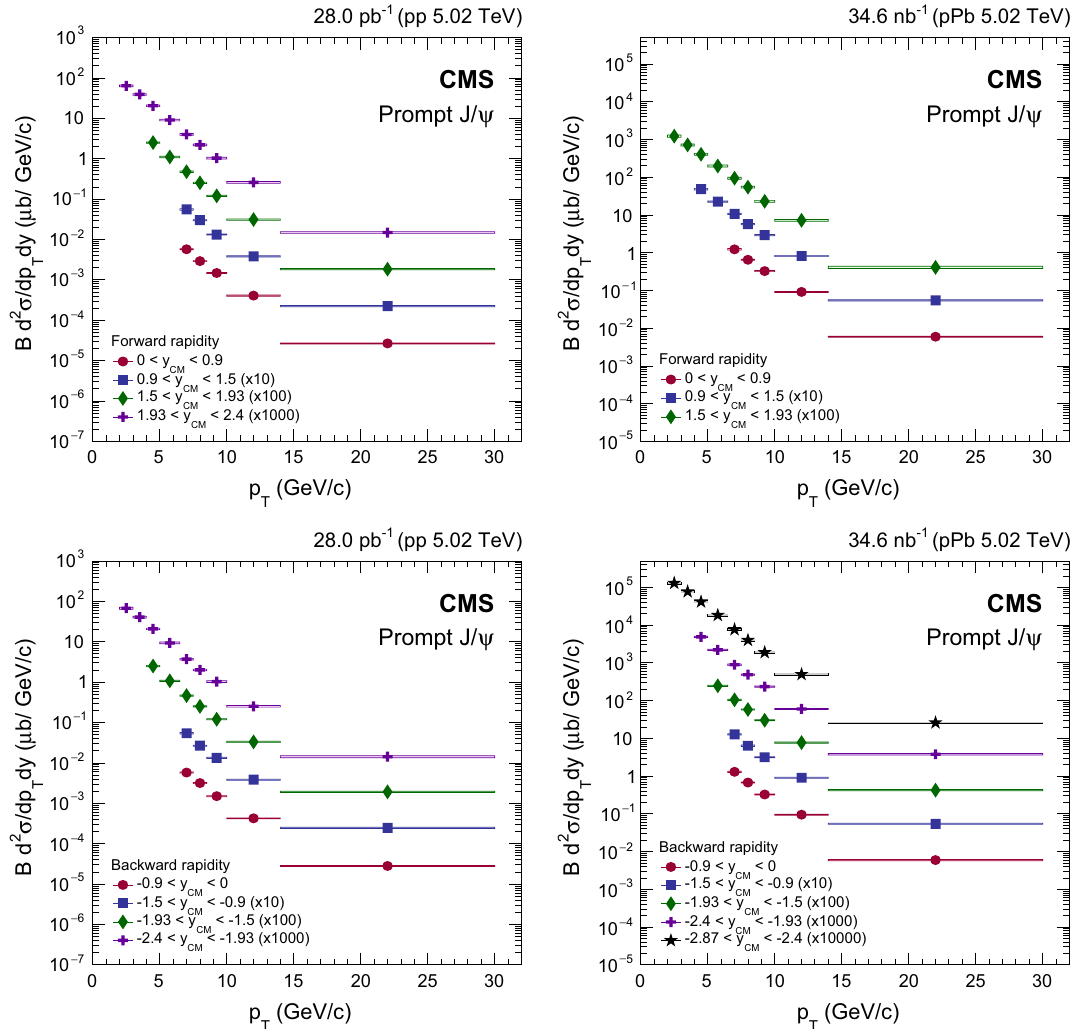
Fig. 2 Differential cross section (multiplied by the dimuon branching fraction) of prompt J /ψ mesons in pp ( left ) and pPb ( right ) collisions at forward ( upper ) and backward ( lower ) y CM . The vertical bars (smaller thanthe symbols inmostcases)representthestatisticaluncertaintiesand